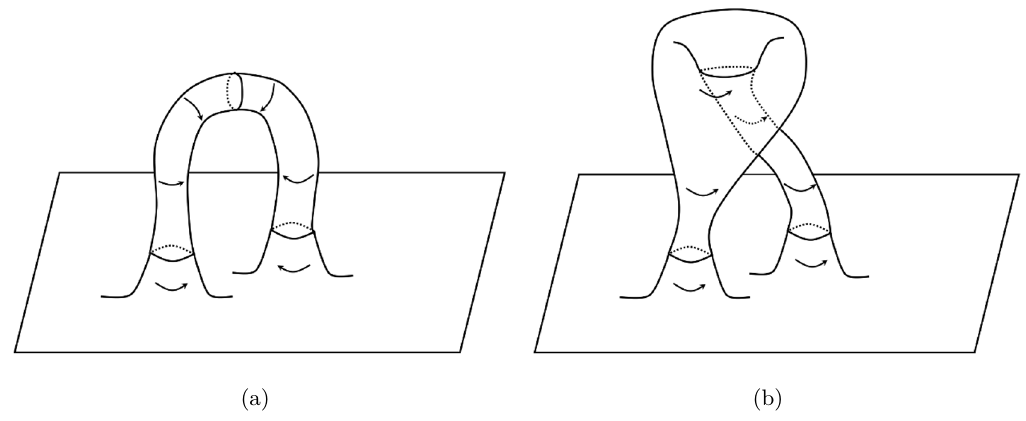
Figure 4 . Spacetime wormholes with orientable (a) and non-orientable (b) Cauchy slices. In the orientable wormhole, conservation of circuital flux demands that the flux reverses direction at the second throat relative to the first throat, while in the non-orientable wormhole the flux at both throats points the same